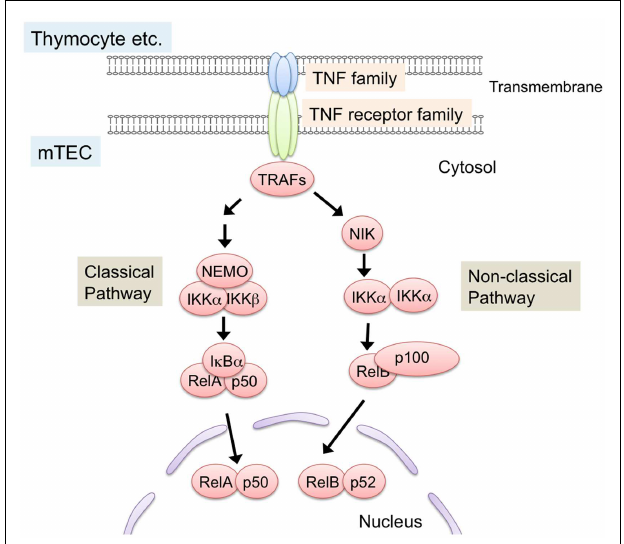
FIGURE 2 | NF- κ B activation pathways triggered byTNF family signaling . Interaction ofTNF family ligand (RANK ligand, CD40 ligand, and lymphotoxin α and β complex) with their respective receptors (RANK, CD40, and Lt β R) induces activation of NF- κ B pathways. Interaction between the ligand and its receptor induce the binding ofTRAF-family proteins to the cytoplasmic domains ofTNF receptors.TRAF-family proteins in turn activate downstream serine/threonine kinase cascade.These kinases trigger the degradation of inhibitory proteins that sequester NF- κ B in cytosol, thereby leading to the translocation and transcriptional activation of NF- κ B members. NF- κ B pathways are classified into classical and non-classical pathway. In the non-classical pathway, NF- κ B complex consisting of RelB and p52 is activated. NIK is critical for the non-classical NF- κ B pathway. TRAF6, a member of theTRAF protein family, was reported to regulate only the classical NF- κ B pathway, which causes nuclear translocation of mainly the RelA complex. On the other hand, otherTRAF members function in the non-classical NF- κ B pathway by binding to theTNF family